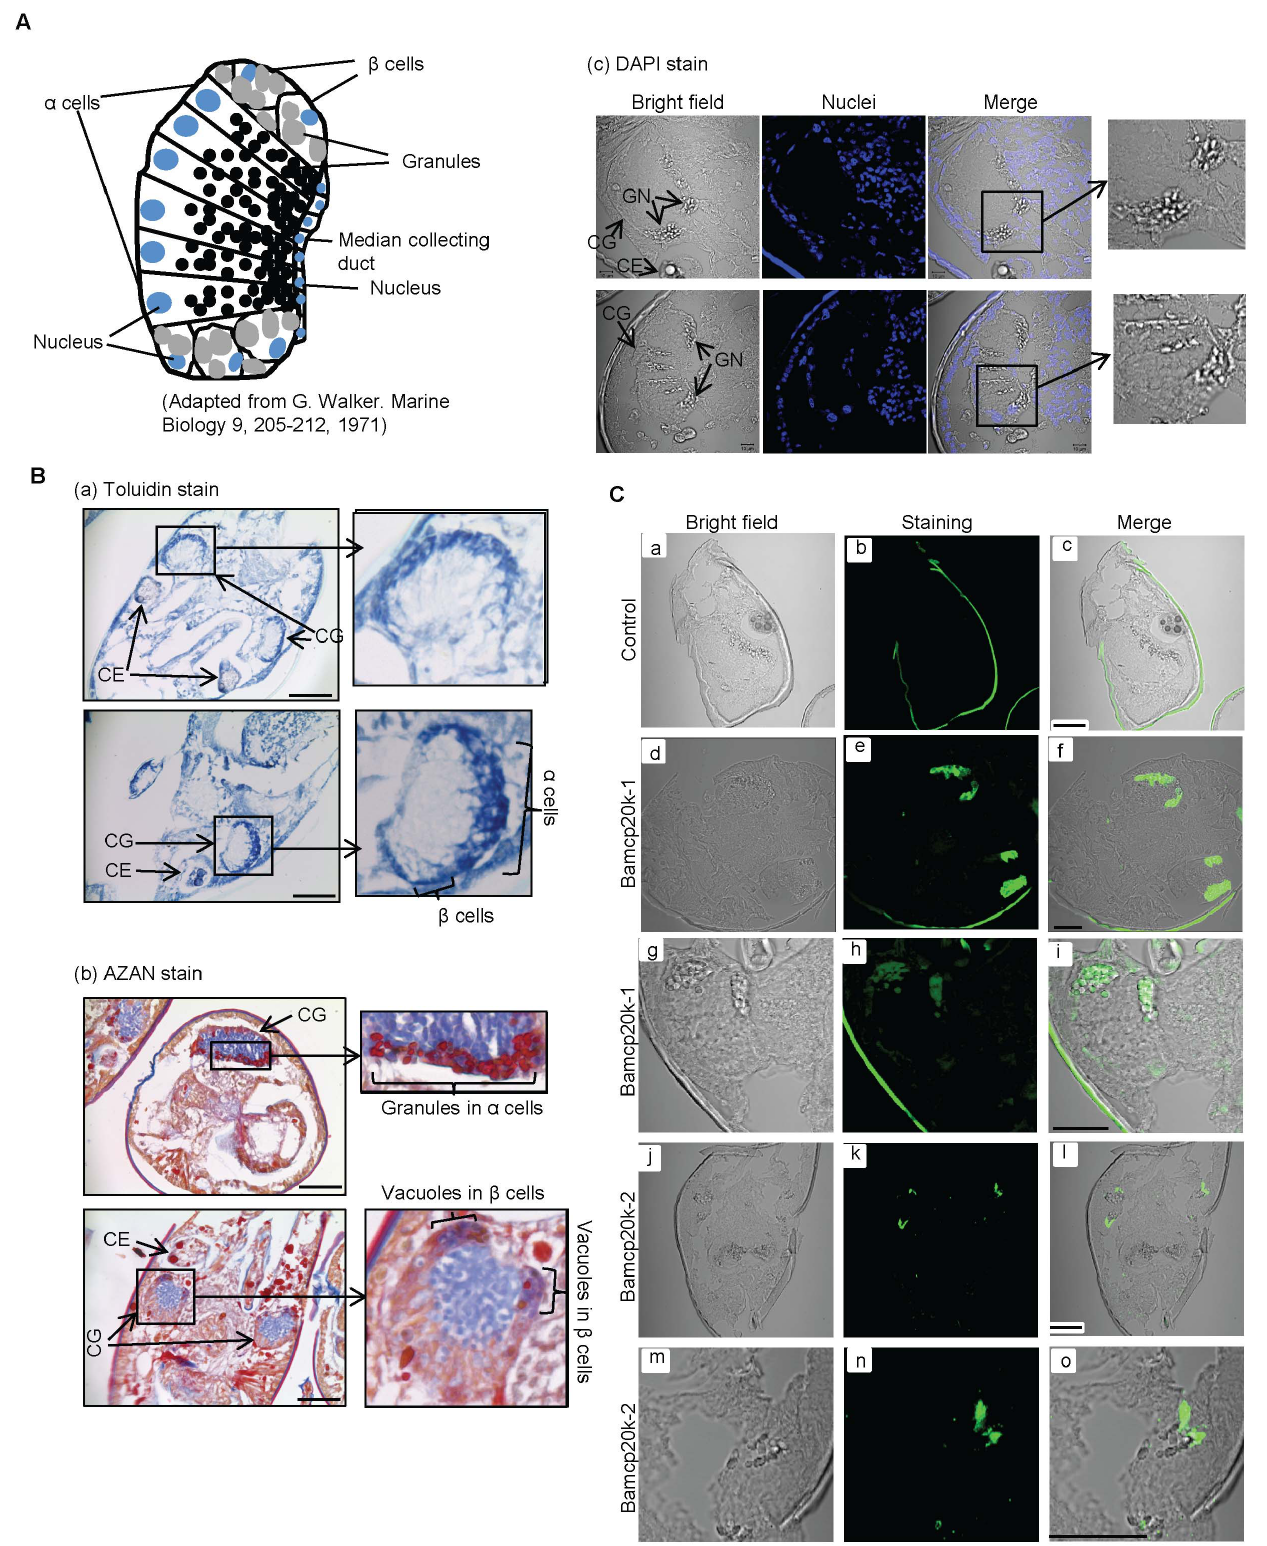
Figure 4. Differential localizations of Bamcp20k-1 and Bamcp20k-2 in cyprid cement glands. (A) The diagram shows the composition of a cement gland in Balanus balanoides . Two types of cement cells ( a and b ) were shown in the cement glands. (B) Cyprids were fixed in 4% PFA and then sectioned after embedding in wax. A section of 4 m m from Amphibalanus Amphitrite was shown. (a) Toluidin stain, Scale bar: 50 m m; (b) AZAN stain, Scale bar: 50 m m; (c) DAPI stain. Nuclei were stained with DAPI. Scale bar: 10 m m. CE: compound eye; CG: cement gland; GN: granules; NC: nuclei. (C) Bamcp20k-1 and Bamcp20k-2 were localized at different cement granules. Sections were immunostained with antibodies against Bamcp20k-1 and